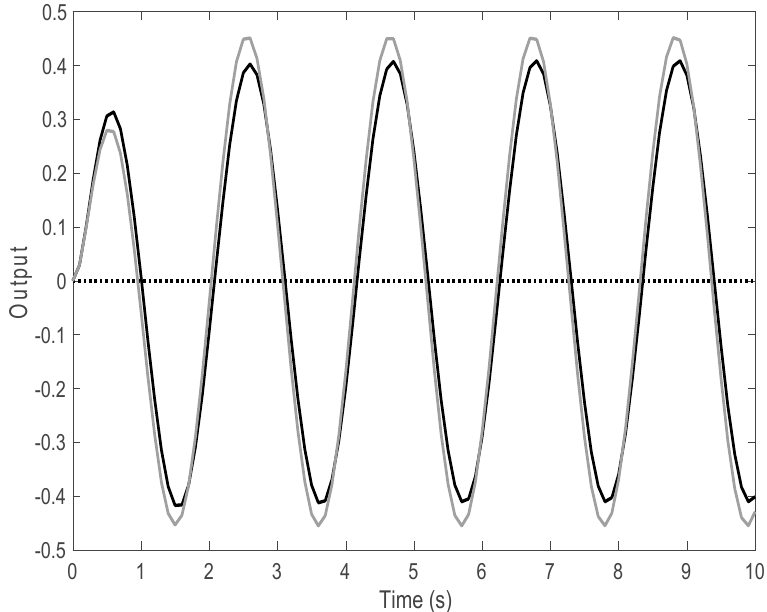
Figure 9. Comparative disturbance rejection results for a simple first-order system.